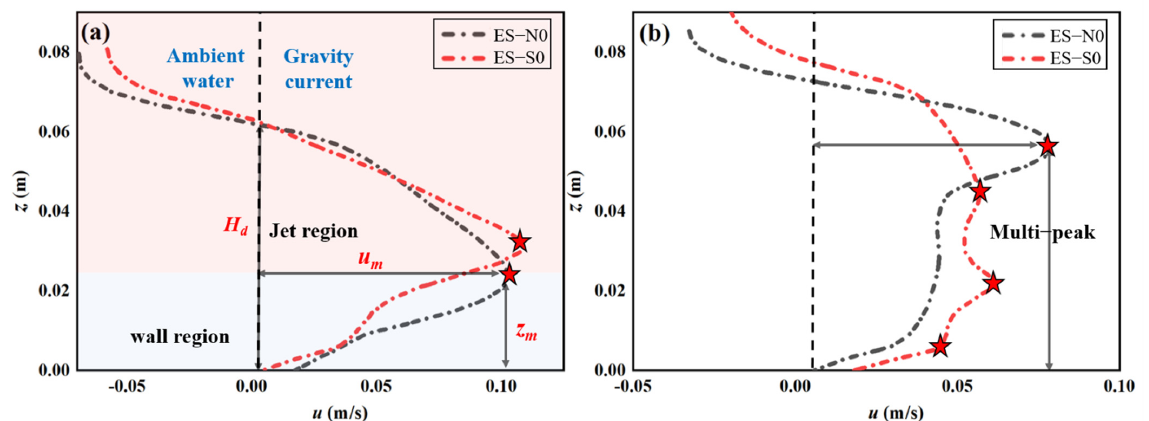
Figure 9. Comparison of the lateral averaged velocity profile in the thickest part of gravity current head in the homogeneous (Run ES-N0) and stratified environments (Run ES-S0), ( a ) t = 8 s; ( b ) t = 16 s. The vertical black dashed line partitions the gravity current from the ambient fluid according to the positive/negative values of u . The red asterisks represent the local maximum of the velocity profile.